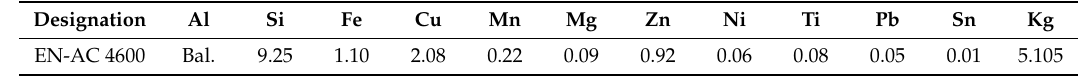
Figure 1. ( a ) Nominal design of the casting part. ( b ) Cross section of the gravity-pouring mould. ( c ) Cross section of the vacuum-assisted mould. Table 1. Chemical composition of the AlSi alloy